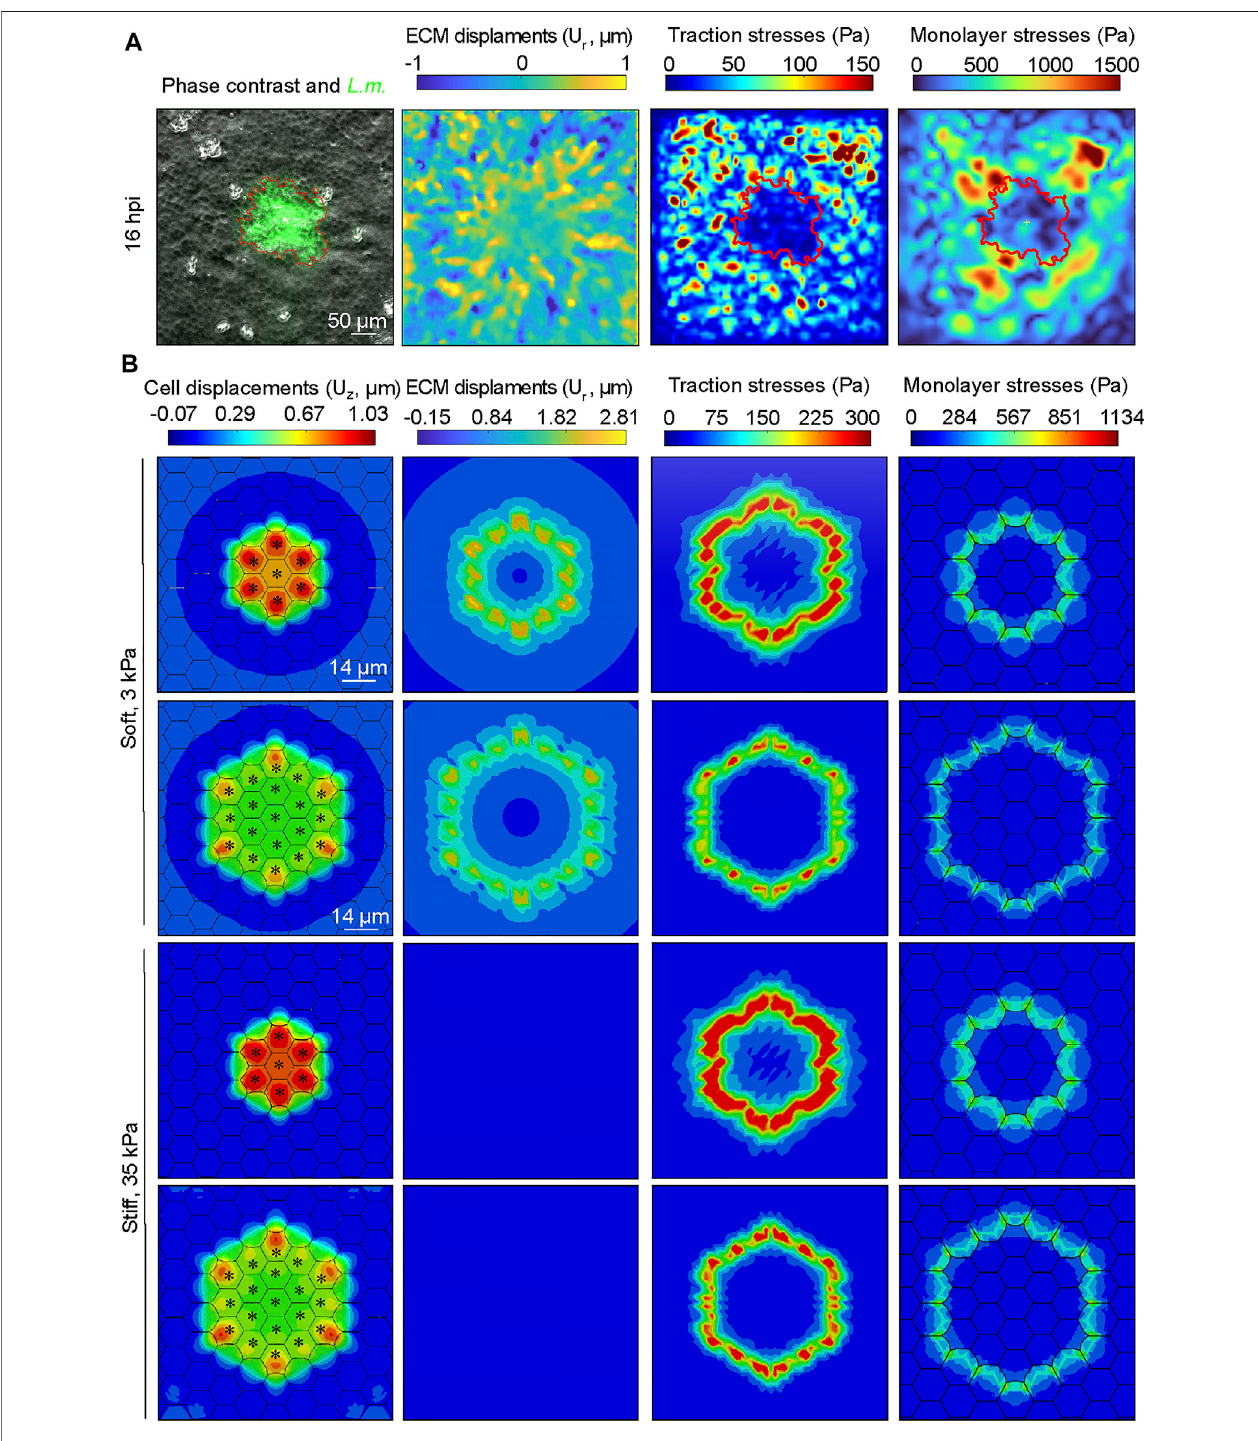
FIGURE6| Monolayer stresses are concentratedat the interface betweeninfected and surrounding uninfected cells both experimentally and in ourcomputational model. (A) ExemplaryimageofMDCK cellsresidingonasoft3 kPahydrogelandinfected with L.m. Timepointshownrefersto16 h.p.i.Fieldofviewimagediscentered aroundaninfectionfocus.Columnsshowfromlefttoright:phasecontrastimageoverlayedwith L.m. fl uorescence(green),radialECMdisplacements( U r :positivevalues indicate displacements pointing away from the focus center, μ m), magnitude of traction stresses exerted by cells on the ECM (Pa), and magnitude of maximum monolayer tangential stresses (Pa). Red contour line indicates the area covered by infected cells (infection focus). (B) Same as panel A but the images depict the corresponding results of the infection computational simulations, with the exception of the fi rst column which shows the con fi guration of the monolayer, the cell vertical displacements( μ m)andwhereinfectedcellsaredenotedbyanasterisk.First(second)rowreferstoasmall(large)focusconsistingof N =7( N =19)infectedcellsresiding on a soft 3 kPa ECM. Third (fourth) row refers to a small (large) focus consisting of N = 7 ( N = 19) infected cells and cells reside on a stiff 35 kPa ECM.